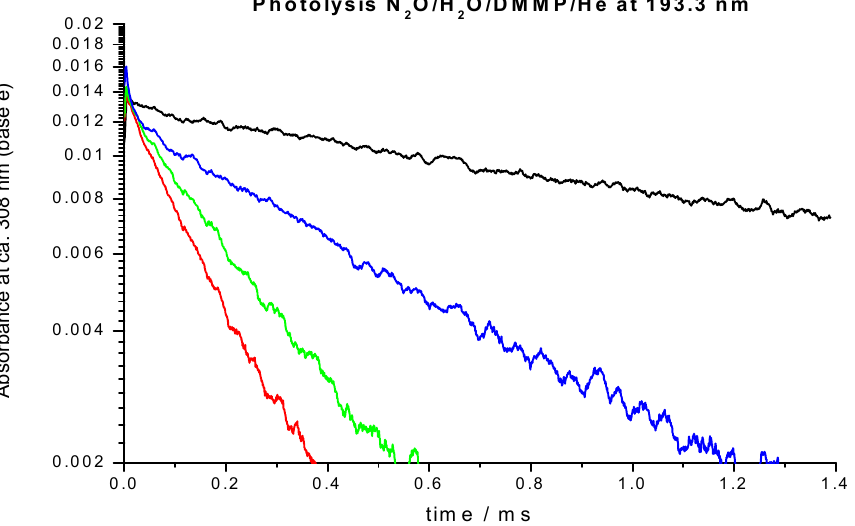
Figure 2. Sample UV absorption profiles of OH radical (multiline at ca. 308 nm). Photolysis of N 2 O/H 2 O/DMMP/He mixtures at 193.3 nm. T = 365 K, p = 1 bar. [N 2 O] = 4.49 × 10 16 molecule cm −3 , [H 2 O] = 2.91 × 10 17 molecule cm −3 , [N 2 O]/[H 2 O] = 0.154. Black—[DMMP] = 0, blue—[DMMP] = 1.92 × 10 14 molecule cm −3 , green—[DMMP] = 5.76 × 10 14 molecule cm −3 , and red—[DMMP] = 9.59 × 10 14 molecule cm −3 .